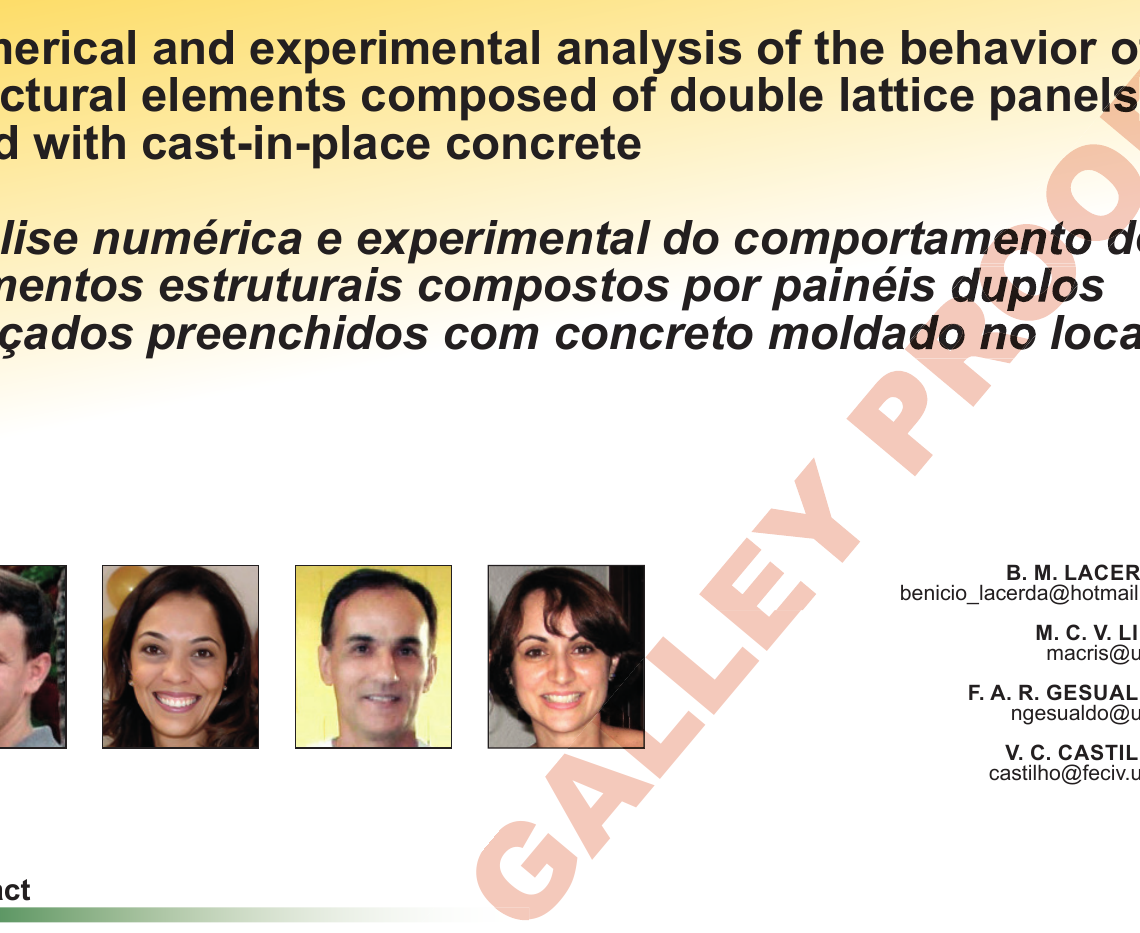
indicated that the transfer of stresses at the interface occurred with loss of adhesion. The numerical simulations indicated that the higher the geo- metric ratio of reinforcement the higher the direct shear strength of the structural model. In general, the slip of the models with smooth interfaces strength when the compressive strength in the region fi lled with concrete increased from 20 MPa to 28.4 MPa. : numerical modeling, experimental analysis, double panels lattice, direct shear, nonlinear analysis.